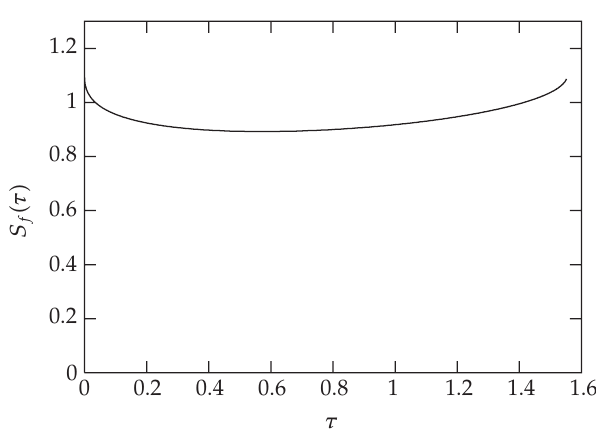
Figure 1.2 . Exercise boundary for the put from ( 1.4 ) for E = 1 . 1, r = 0 . 05, D 0 = 0 . 01, and σ = 0 .